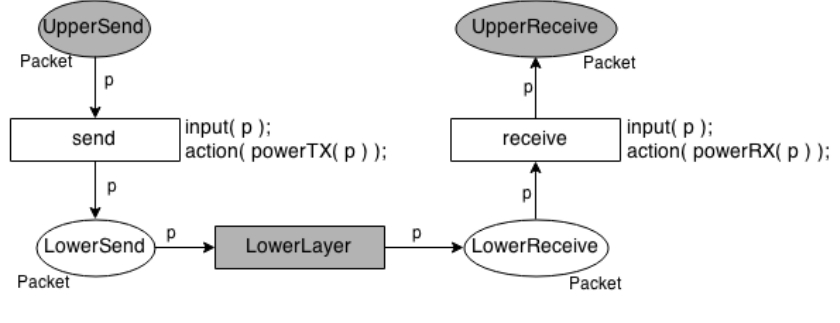
Figure 6. Template of protocol models.